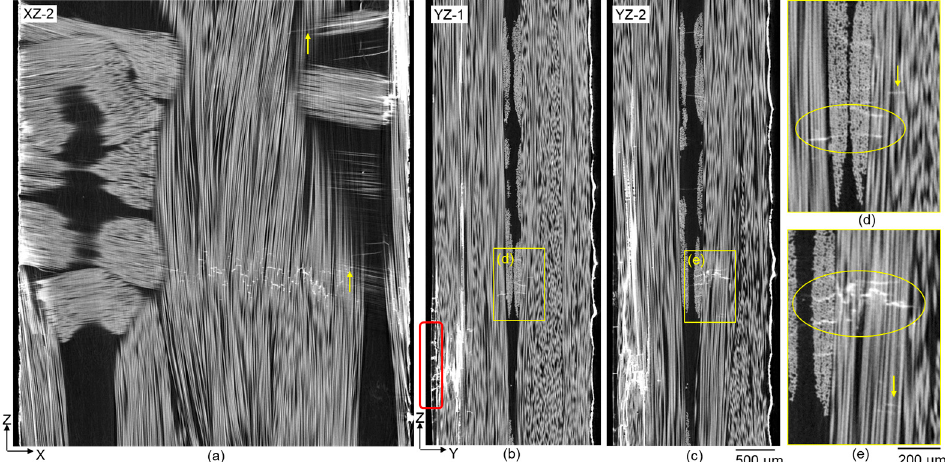
Figure 5. X-ray CT virtual ( a ) XZ-2 and ( b ) YZ-1 and ( c ) YZ-2 sections (positions indicated in Figure 3b,c) recorded after 500,000 cycles showing crack paths connecting off-axis cracks in the backing fibre bundles and fibre fractures in the UD fibre bundles. ( d , e ) Magnfied views of the highlighted regions in ( b , c ) showing the connected off-axis cracks (marked with ellipses) and also isolated UD fibre fractures (marked with downward-arrows).